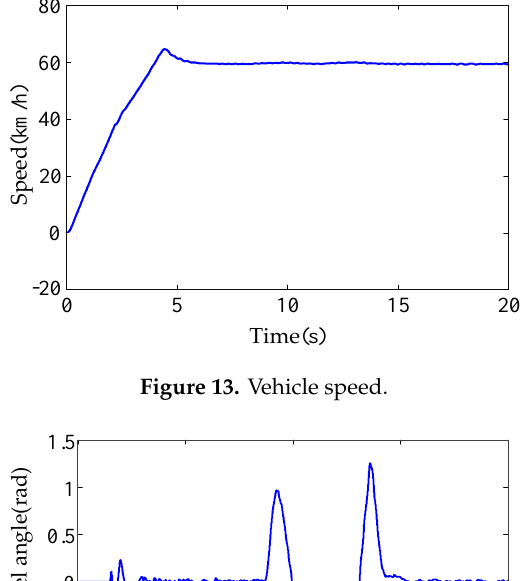
Figure 13. Vehicle speed.